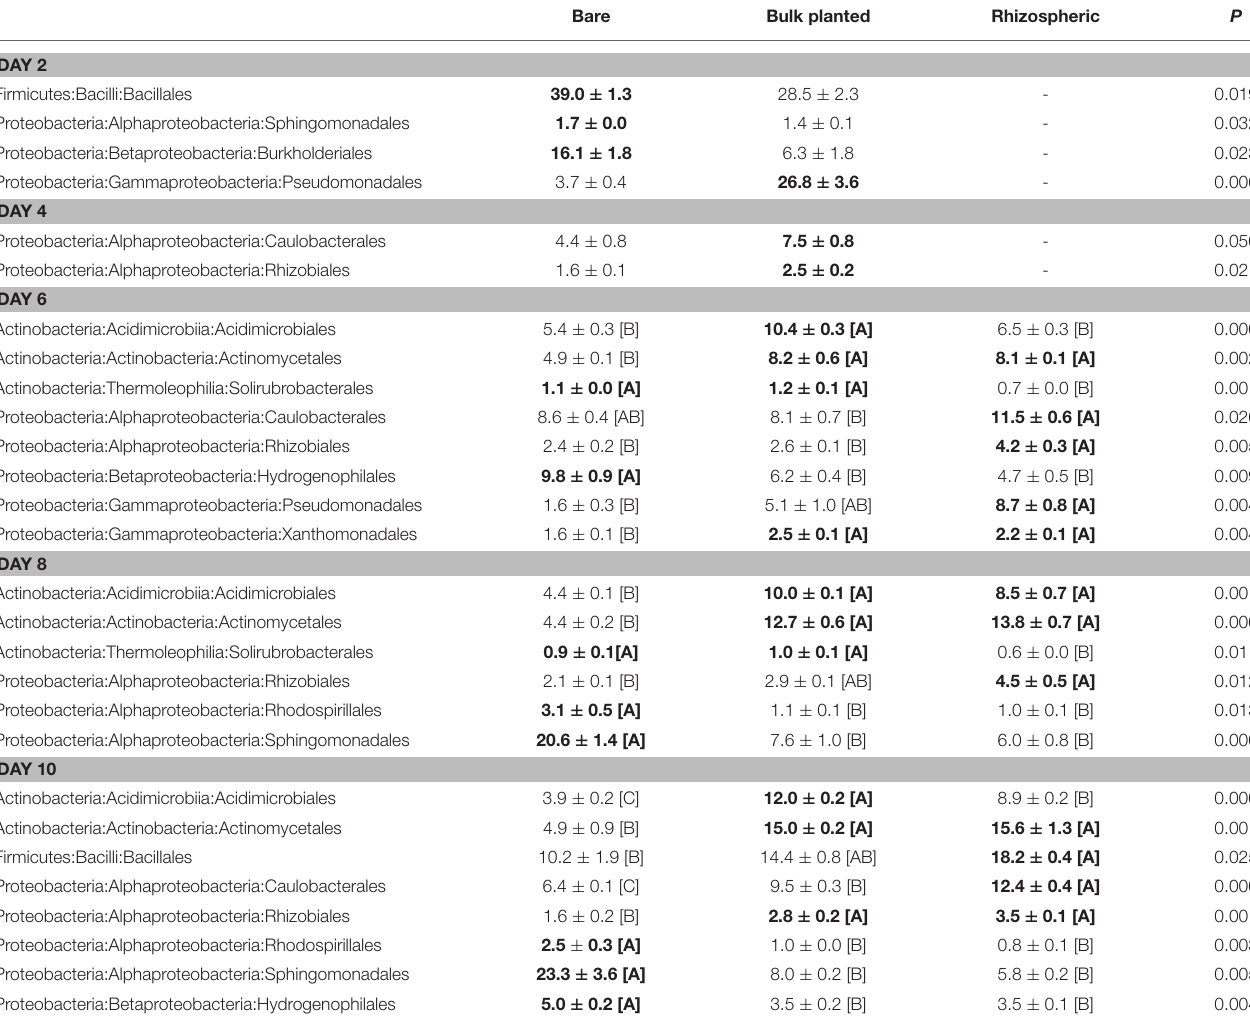
TABLE 2 | Relative proportion of bacterial orders that significantly ( P < 0.05 ) change with plant growth, based on data from cDNA libraries. Bare Bulk planted Rhizospheric